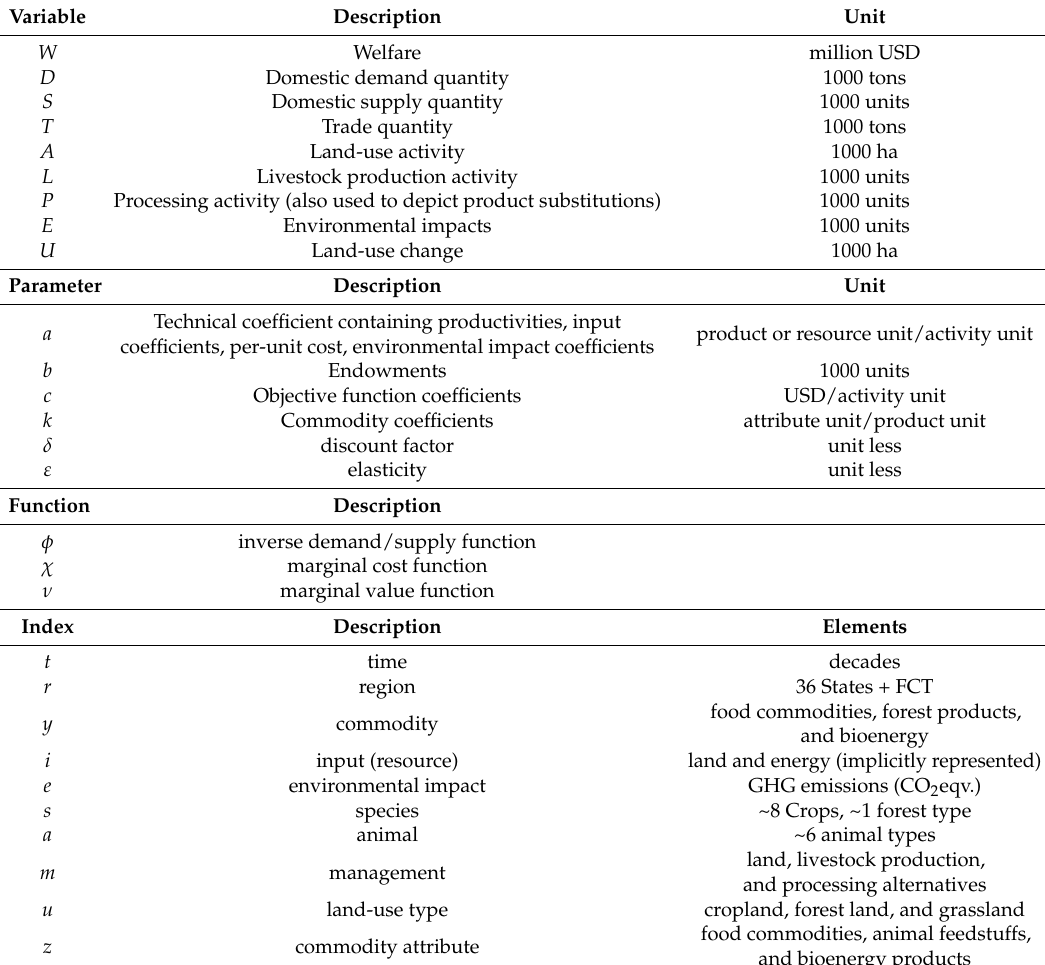
Table A1. Description of Variables, Parameters, Functions and